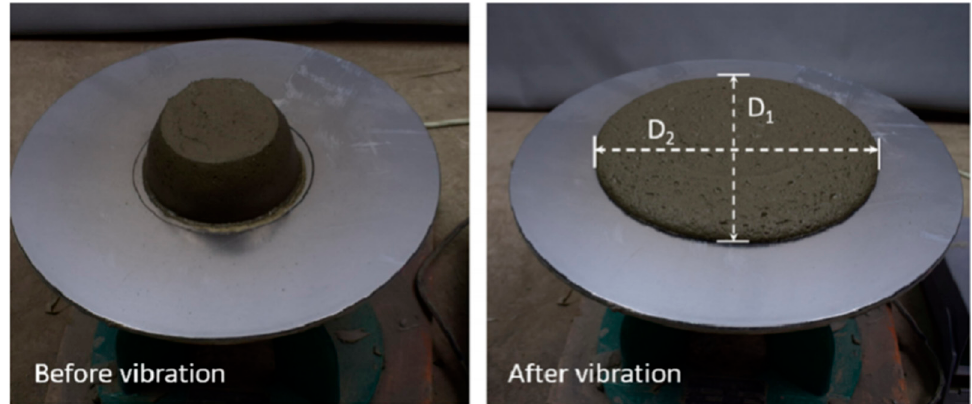
Figure 3. Jump table test employed for flowability measurement. Reprinted with permission from ref. [21]. Copyright 2017 Elsevier